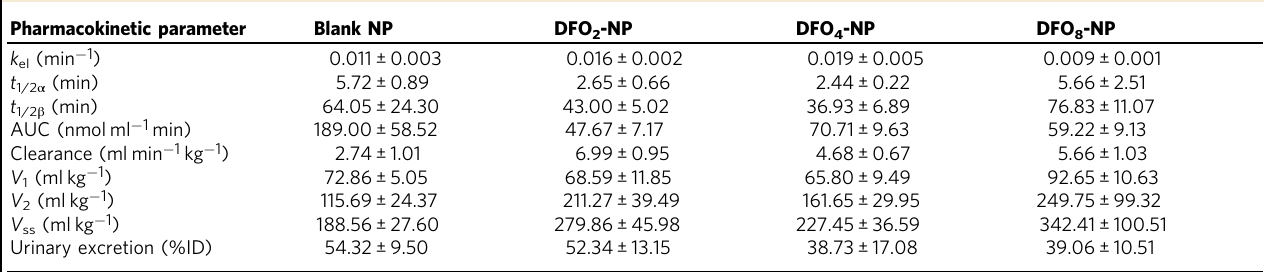
4 h post-injection, DFO-NPs did not show any nonspeci fi c biodistribution, even at the highest dose tested (2 µmol kg − 1 ), and were exclusively excreted through the urine. No hepatobiliary excretion was detected during the 24 h biodistribution (Supple- mentary Fig. 12, Movies 1 and 2). The dose – renal excretion (% ID) relationship showed more ef fi cient excretion of DFO 4 -NPs than that of DFO 8 -NPs (Fig. 2d) due to the difference in physicochemical properties including charge-to-mass ratio. Interestingly, after administering high dose of DFO 4 -NPs